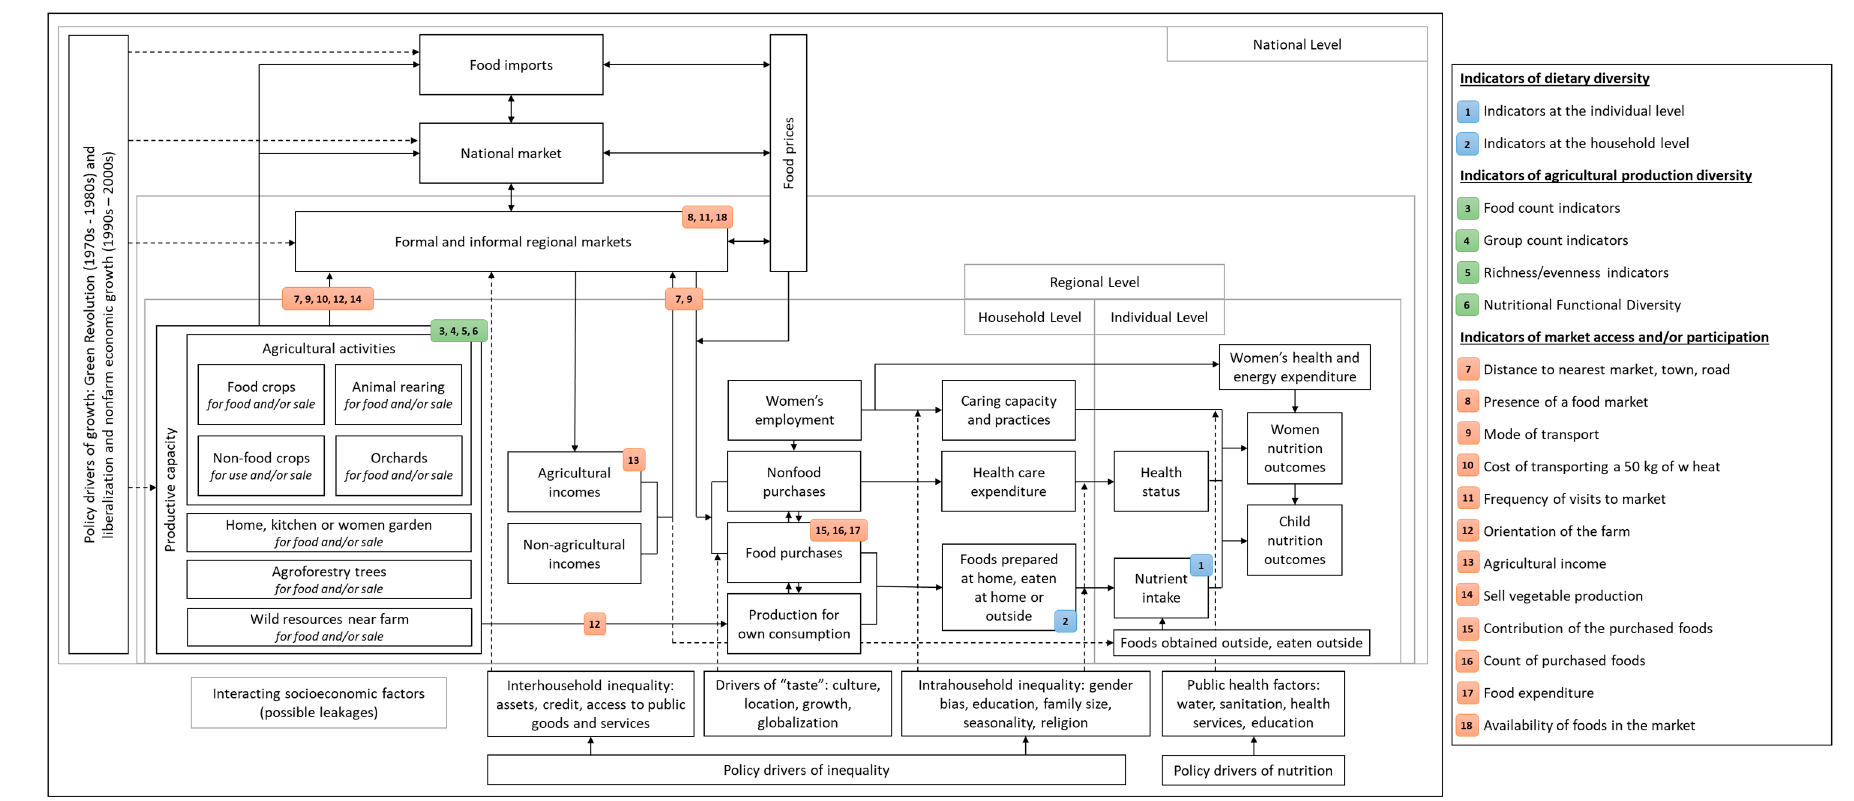
Figure 1. Mapping the indicators of agricultural production diversity and the indicators of market access and/or participation in the agriculture–nutrition pathways.